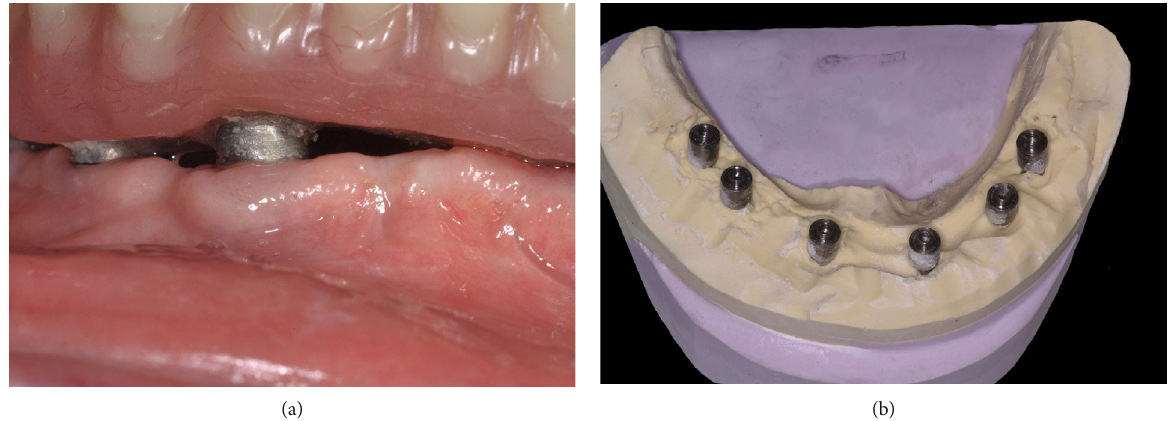
Figure 4: Preparation after osseointegration and gingival recession. (a) After healing, clearance between the alveolar crest and the denture. (b) Stone was eliminated between the implant abutment analogs on the master cast model.